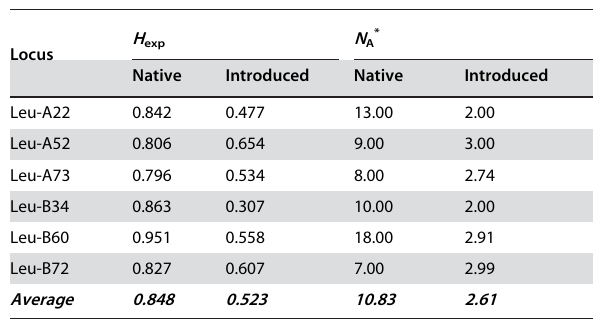
Table 1. Expected heterozygosity, H exp , and average allelic richness, N A in native and introduced L. leucozonium